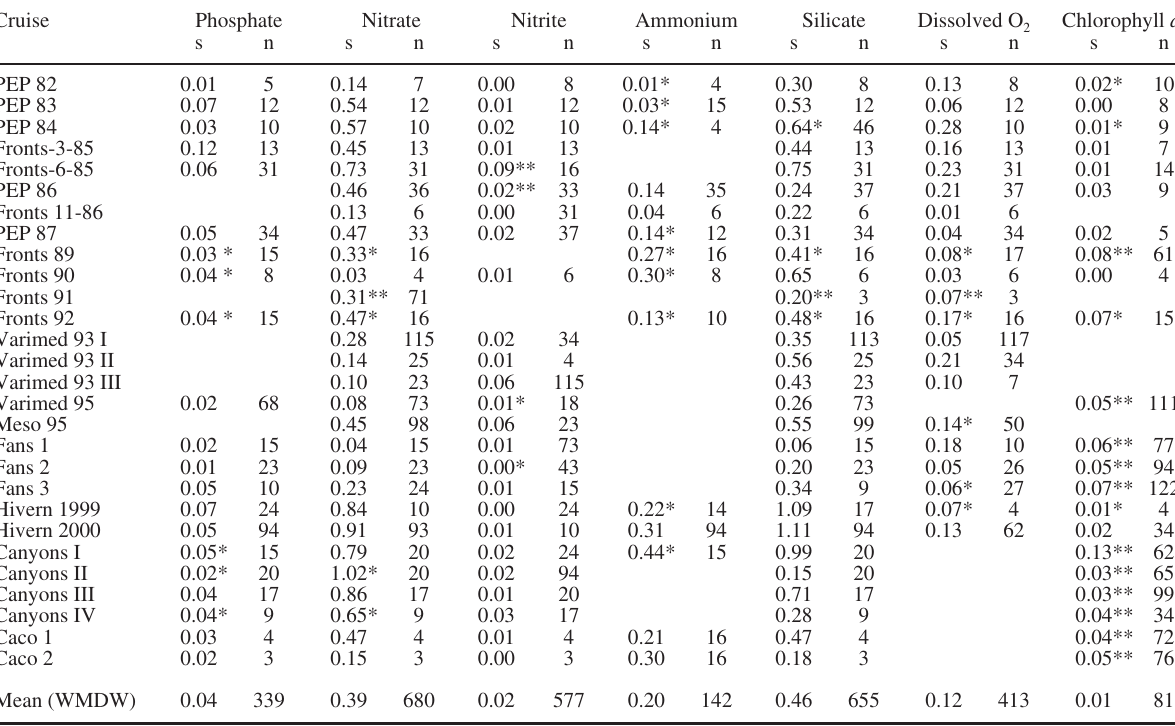
Table 4. – Analysis precision estimated for each cruise and oceanographic variable using the methodology described in Garcia et al. (1988) using data from WMDW, from the core of the LIW (*), and using all LIW data (**). The mean value was calculated using all the data at the